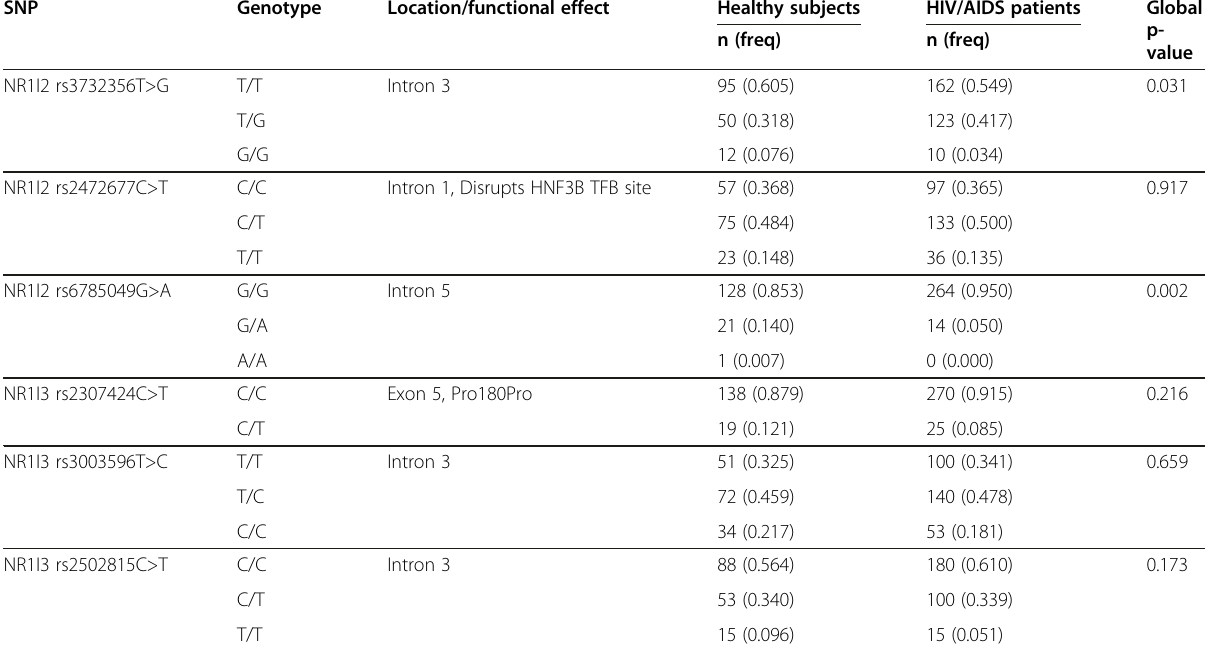
Table 2 Comparison of the genotype frequencies between control subjects and HIV/AIDS patients